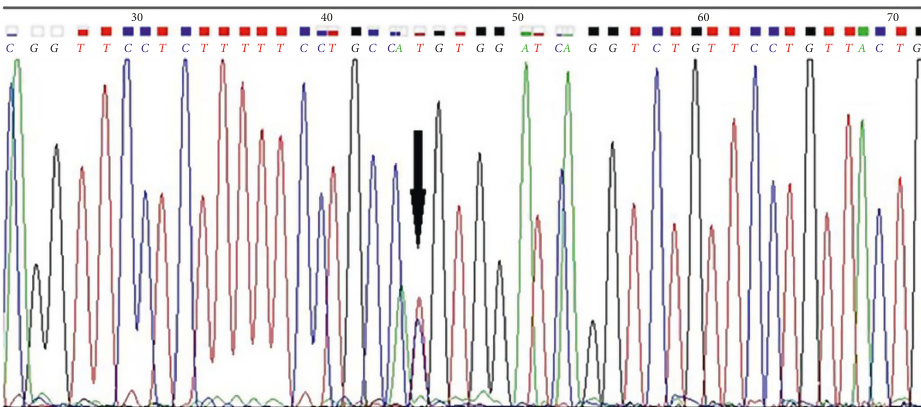
Figure 2: Electropherogram of the locus containing the mutation revealed by Sanger sequencing. The black arrow indicates the point mutation.